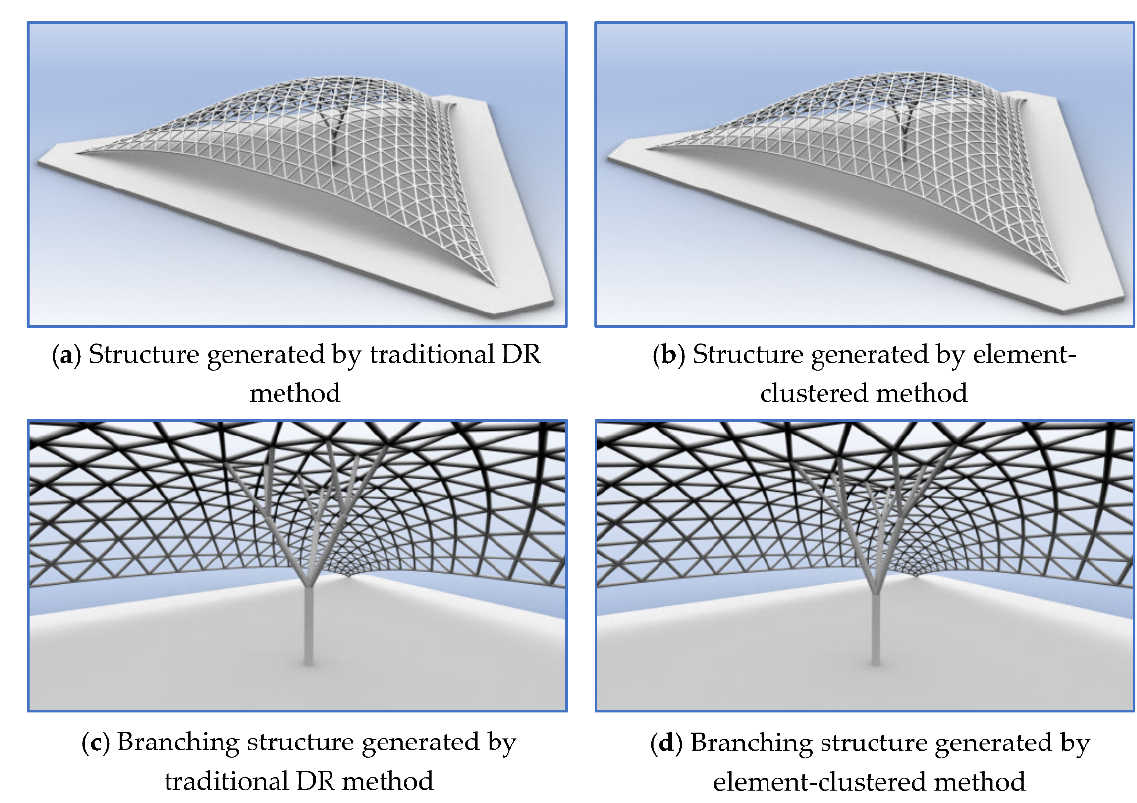
Figure 2. Initial hanging model.